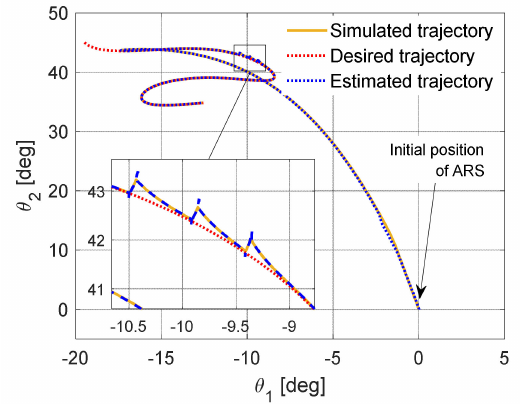
Figure 17. Simulated, desired, and estimated trajectories of ARS—LQG